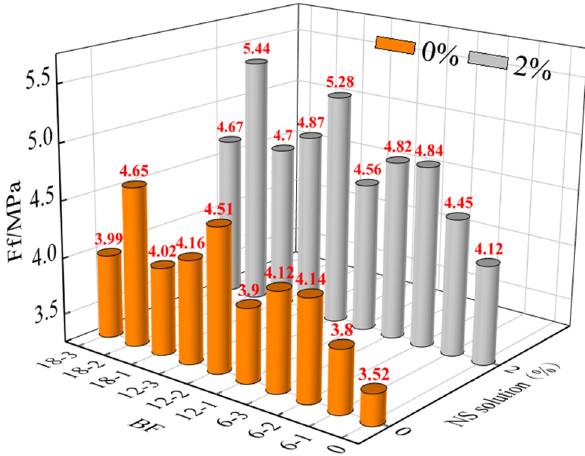
Figure 15: The synergistic e ff ect of NS and BF on the fl exural strength of RAC.